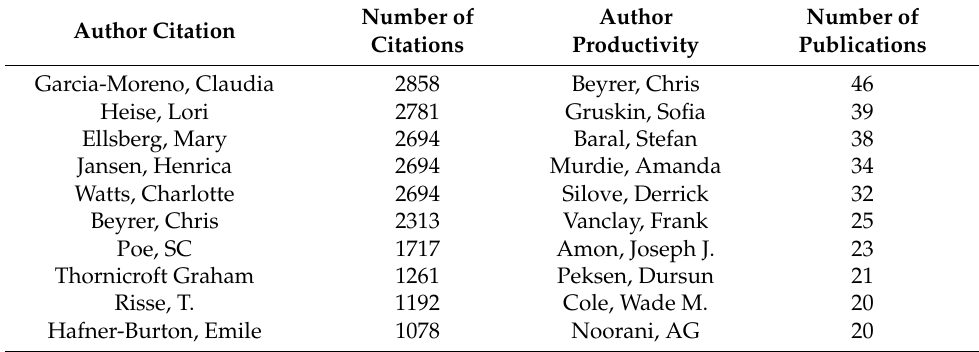
Table 1. Most cited/productive authors from 1990 to June